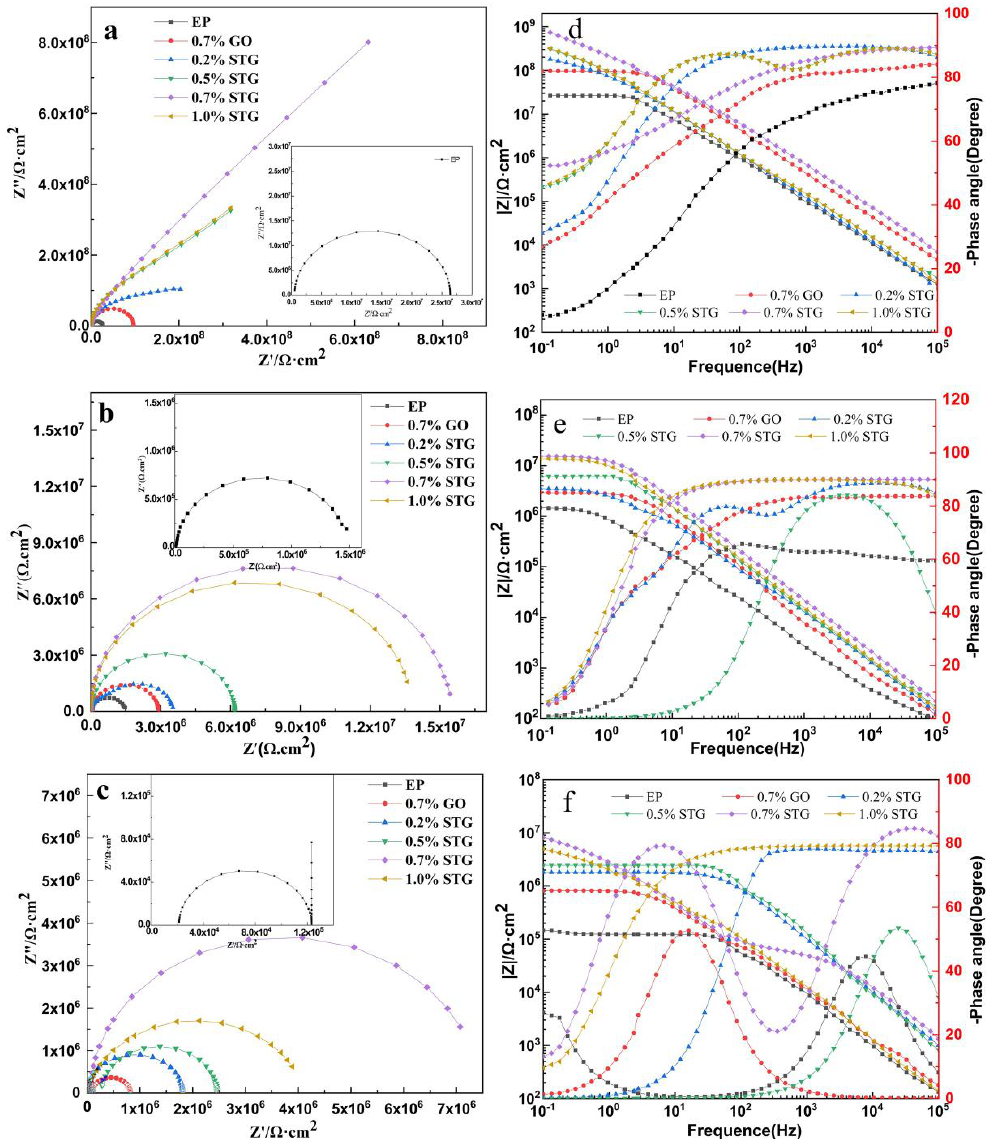
Figure 6. The Nyquist and Bode plots of different samples after 2 h ( a- Nyquist , d- Bode), 360 h ( b- Nyquist, e- Bode) and 720 h ( c- Nyquist , d- Bode) immersion in 3.5 wt.% NaCl solution.